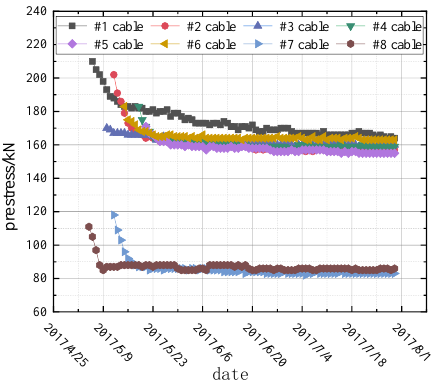
Figure 10. Prestress monitoring values of #1–#8 anchor cables.